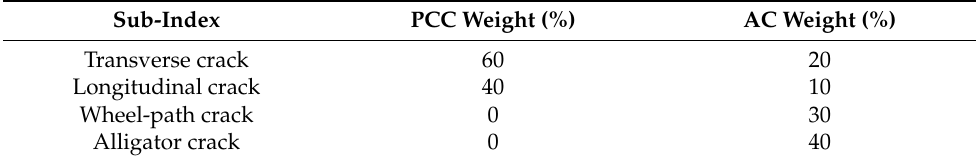
Table 2. Weight of each sub-index for calculating the cracking index. Sub-Index PCC Weight (%) AC Weight (%) Transverse crack 60 20 Longitudinal crack 40 10 Wheel-path crack 0 30 Alligator crack 0